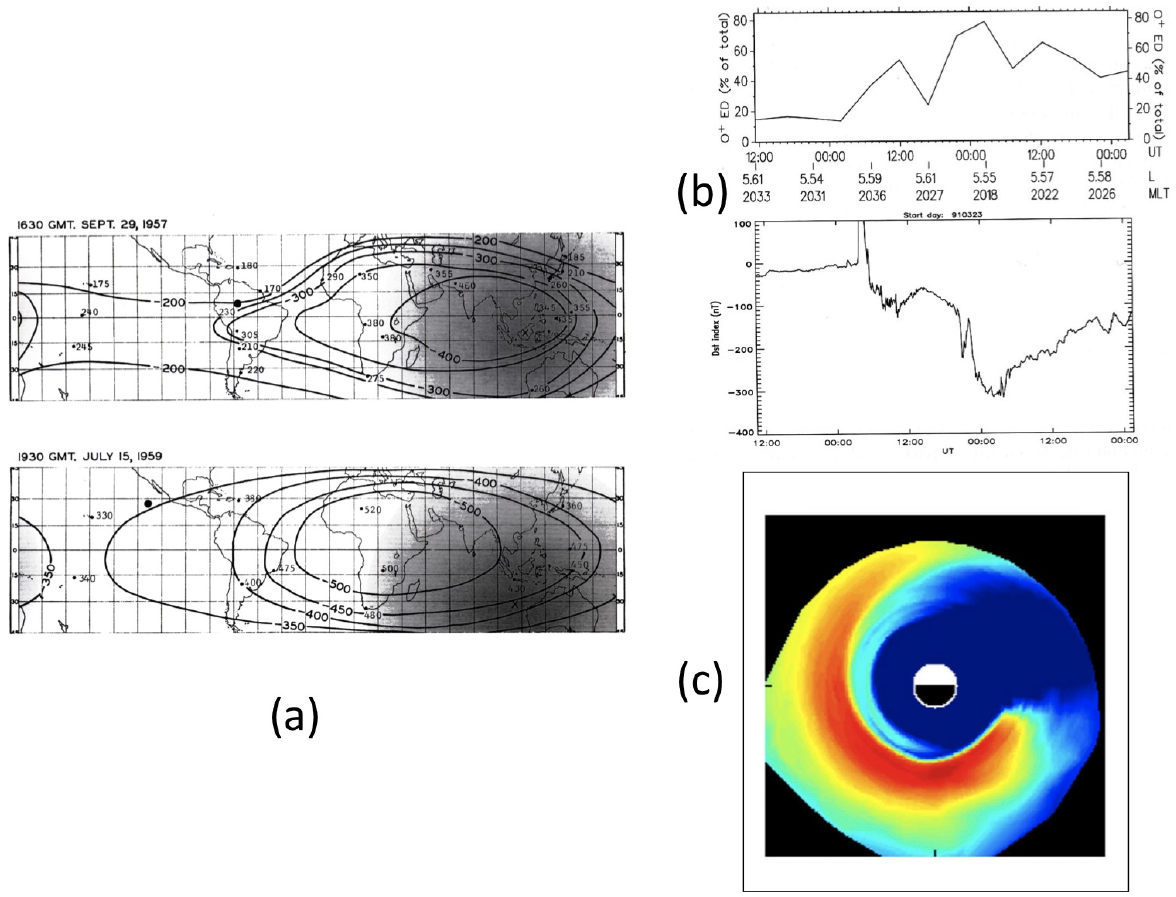
Figure 11. (a) A large asymmetric development of the main phase for two geomagnetic storms; the nightside is indicated by a dark shade (Akasofu and Chapman, 1964). (b) The O + ion flux and the Dst index (Daglis, 1977) and the simulated distribution of O + ions (Fok et al.,